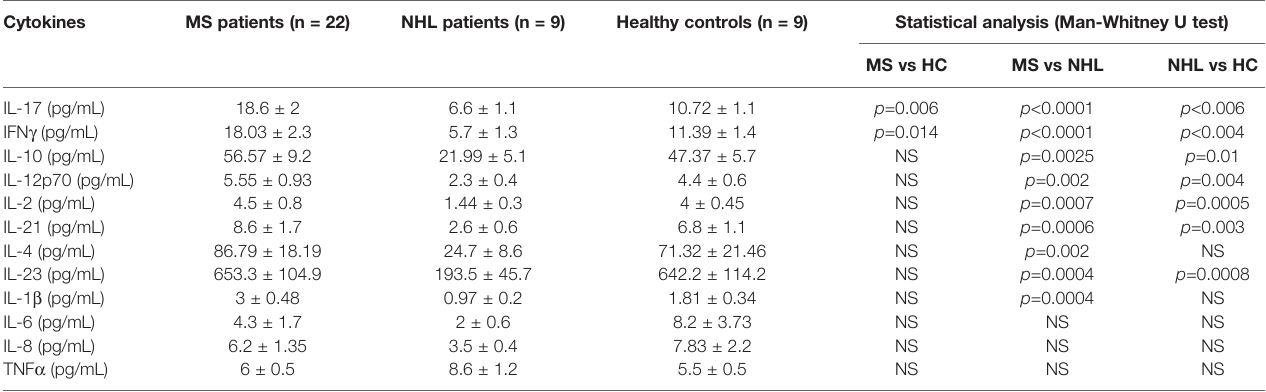
TABLE 2 | Comparison of plasma cytokine levels between MS and NHL patients before transplantation and healthy controls. Cytokines MS patients (n = 22) NHL patients (n = 9) Healthy controls (n =